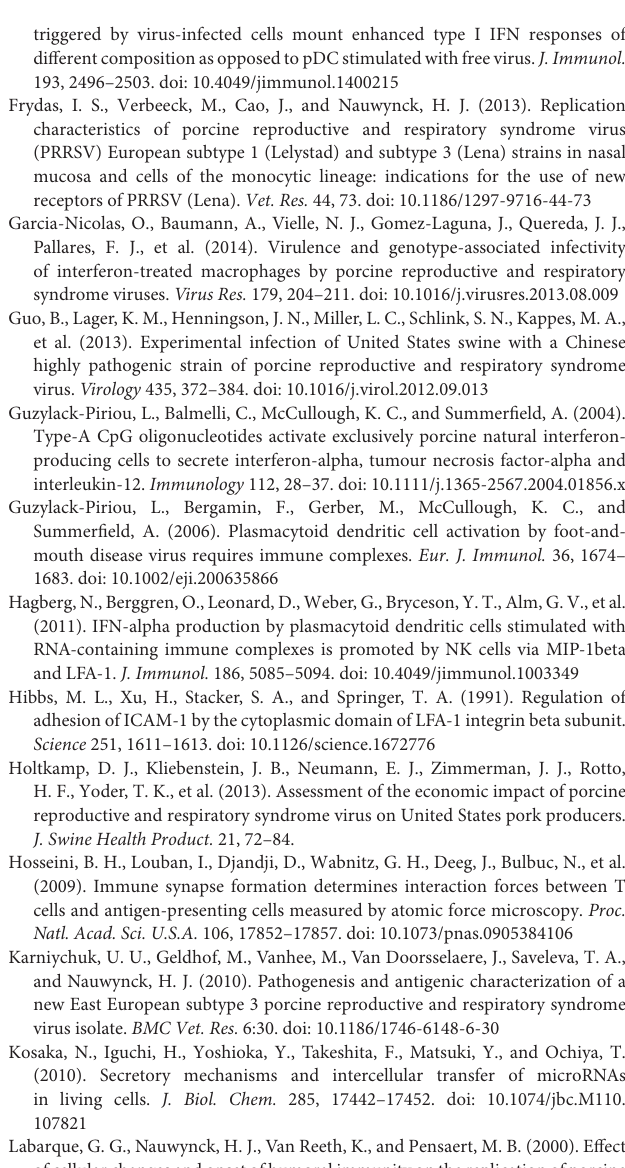
FIGURE S1 | GW4869, a non-competitive inhibitor of N-SMase neither affects TLR9 nor TLR7 signaling in pDC nor PRRSV infection and replication in MØ. pDC were stimulated with TLR9 ligand CpG D32 (A) or with TLR7 ligand Gardiquimod (B) and treated with DMSO control at different concentrations (0.1, 0.2, and 0.4% v/v), in presence or absence of GW4869 at 5, 10, and 20 µ M. These results demonstrate that IFN- α production by pDC was not affected by N-SMase inhibitor (GW4869) at any tested concentration. (C) MØ were infected with PRRSV Lena in the presence of GW4869 during the virus adsorption incubation time. After 90 min, the cells were washed and incubated for 16 h before PRRSV N expressing cells were quantified by flow cytometry; demonstrating that this inhibitor does not affect the virus entry into the target cells. In (D) GW4869 was present only after the 90 min adsorption period, which shows that GW4869 has no effect on the viral replication in MØ. (E) PRRSV virus titres in supernatant collected from (C) . (F) PRRSV RNA levels in supernatants of (C) quantified using RT-qPCR. Both (E,F) confirm observations previously done in (D) . Significant differences between conditions are indicated by asterisks based on the Mann–Whitney test ( ∗ P <